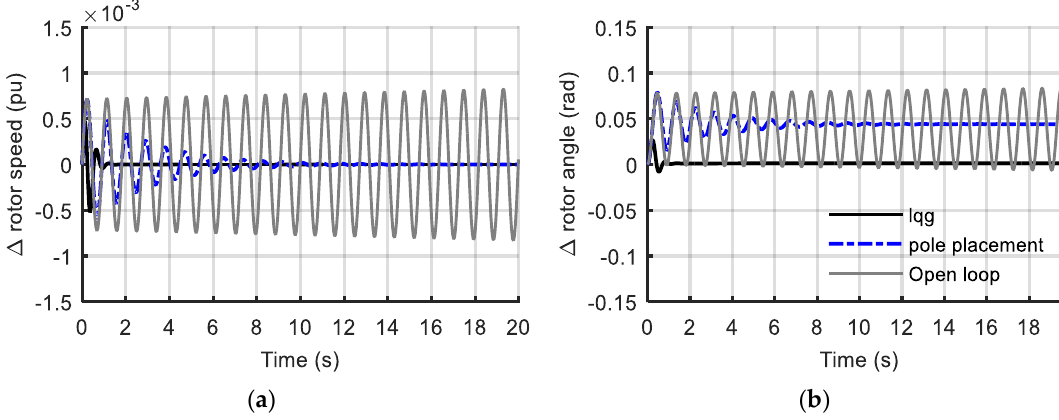
Figure 5. SG performance due to 0.05 pu step load demand at P = 1.1 pu, Q = 0.1 pu. ( a ) Rotor speed deviation; ( b ) Rotor angle deviation.